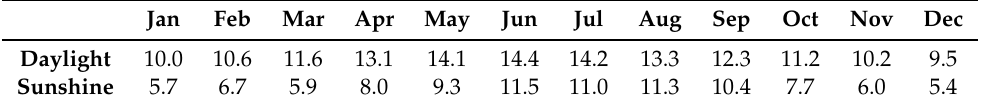
Table 2. The average of daylight and the minimum sunshine in hours (h) in Tehran for 2019 [37]. Jan Feb Mar Apr May Jun Jul Aug Sep Oct Nov Dec Daylight 10.0 10.6 11.6 13.1 14.1 14.4 14.2 13.3 12.3 11.2 10.2 9.5 Sunshine 5.7 6.7 5.9 8.0 9.3 11.5 11.0 11.3 10.4 7.7 6.0